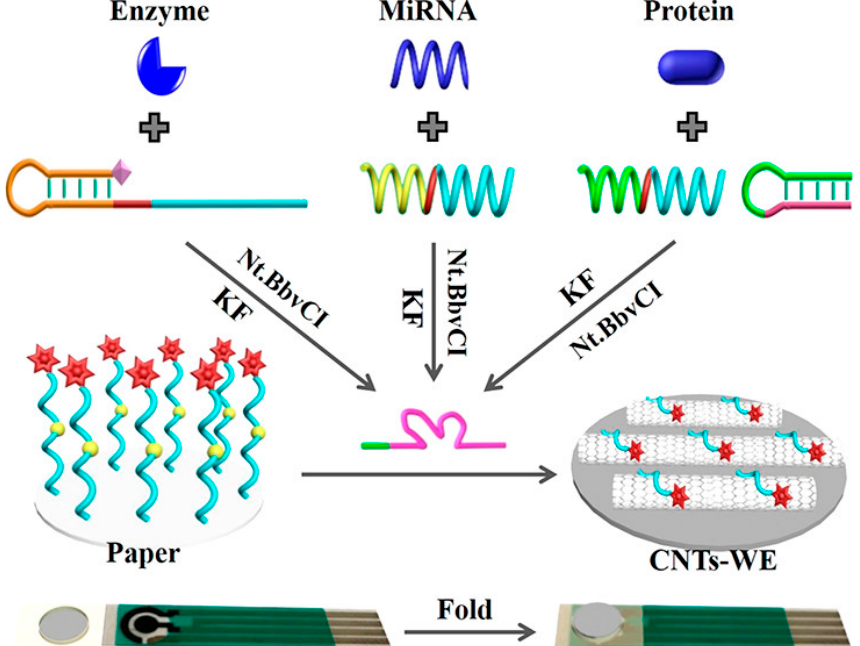
Figure 6. Scheme of the use of commercial screen-printed electrodes combined with a functionalized paper. MiRNA: microRNA; KF: Klenow fragment; Nt.BbvCI: nicking endonuclease. Reprinted from [56] with permission from American Chemical Society (ACS).